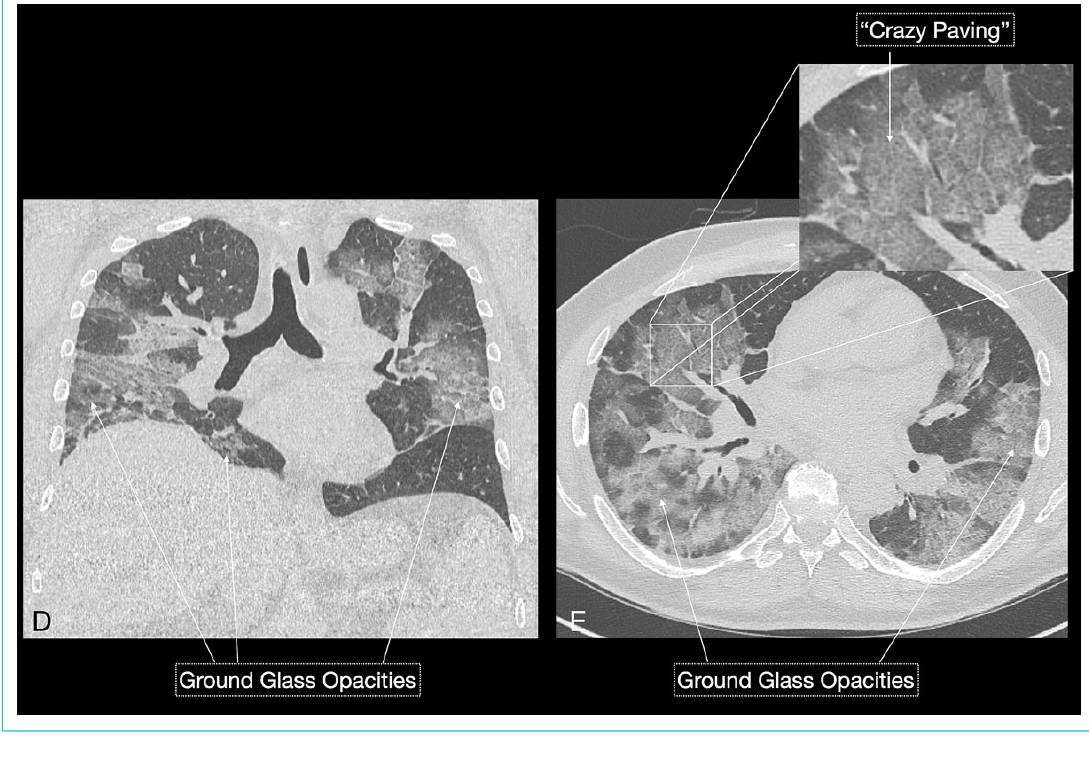
Figure 6 DE: Over time the patient’s dyspnoea increased and the subsequent chest CT scan (D, E) confirmed worsening disease with in- creasing ground glass opacities and an apparent “crazy paving” pattern, the latter suggesting a progressive stage of disease.